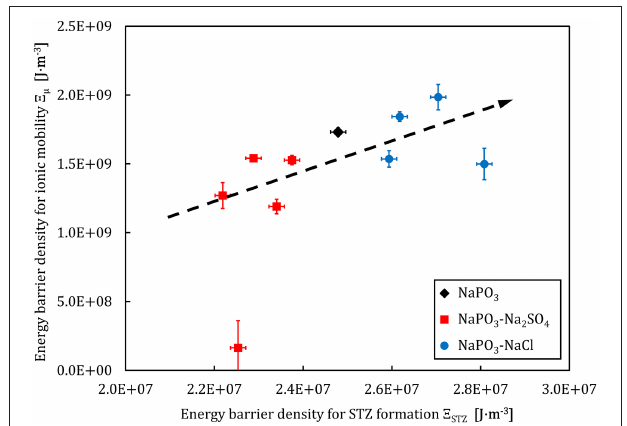
FIGURE 10 | Walden plot presenting the conductivity data of the NaPO 3 -NaCl-Na 2 SO 4 glasses in comparison with the AgPO 3 -AgX glass system ( Rodrigues et al., 2019). The lines show the linear regressions of the experimental data, with a slope of 1.2 ± 0.1 for the NaPO 3 -NaCl-Na 2 SO 4 glasses and of 1.08 ± 0.02 for AgPO 3 -AgX glasses. The regression was performed between 10 4 and 10 6 Hz where experimental data is available for all samples, to avoid biasing the result.